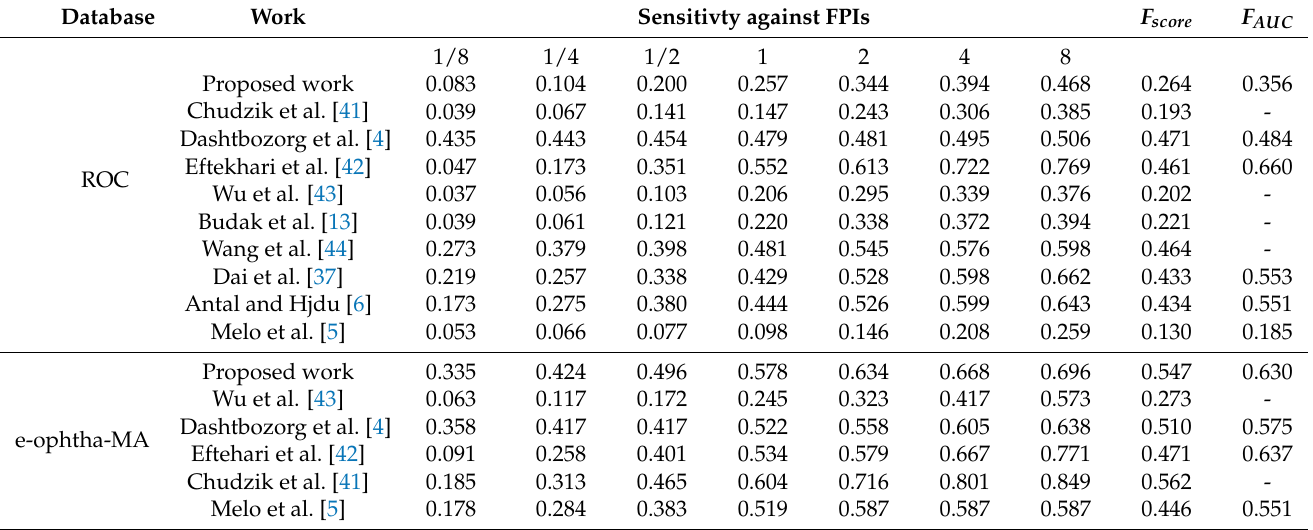
Table 6. Performance of different MA detection methods in the ROC and e-ophtha MA